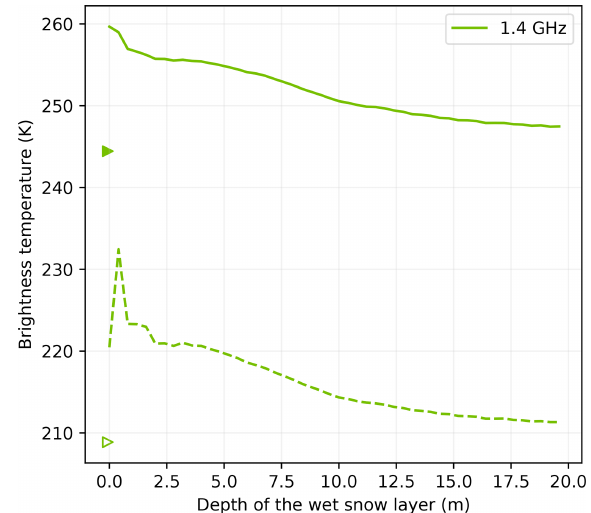
Figure 17. Brightness temperature at Roi Baudouin as a function of the total liquid water content in the top 30cm of the snowpack at the L band at V-pol (solid) and H-pol (dashed) (a) . The simulated dry brightness temperatures are marked by the triangles. Distribu- tion of observed brightness temperature when the surface is melting according to Jakobs et al. (2020) (b) .